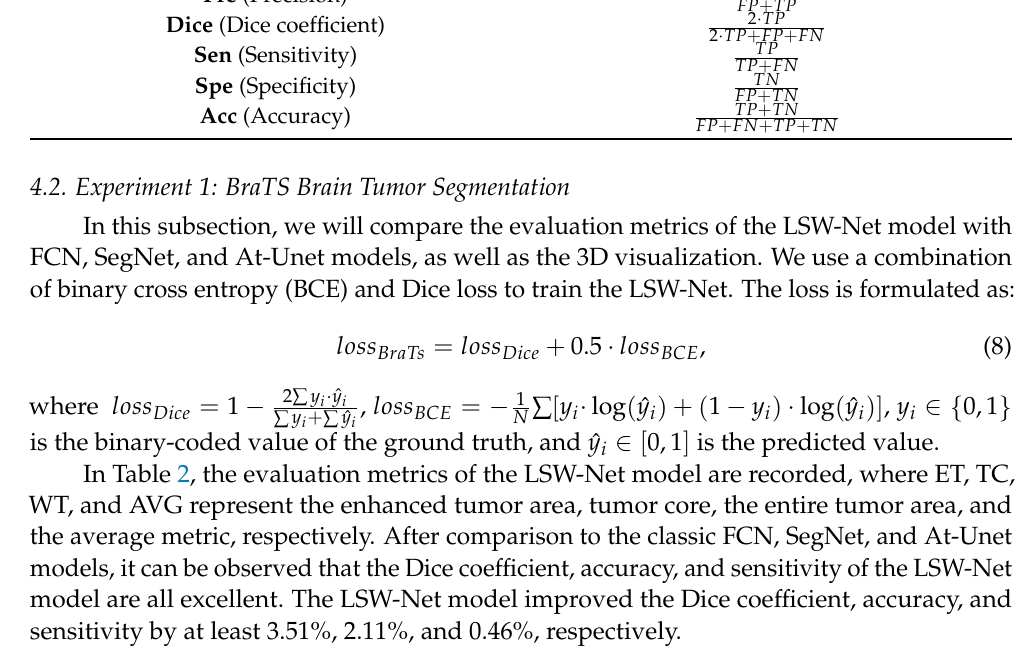
Table 2. Comparison of LSW-Net model with classical segmentation algorithms on